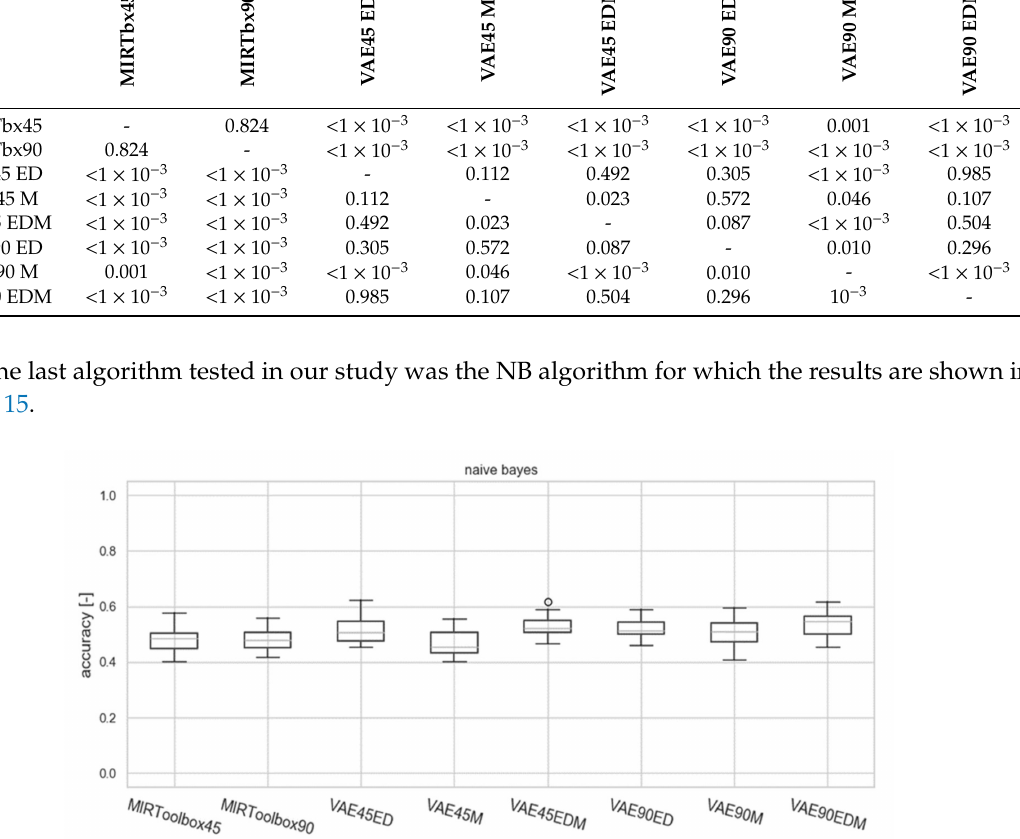
Figure 15. Accuracy obtained based upon the NB classifier shown as a boxplot.